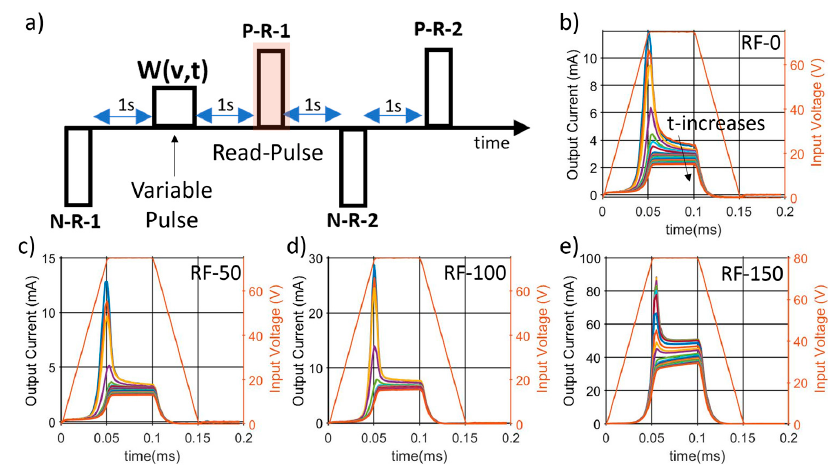
Figure 7. ( a ) Modified PUND method to analyze the polarization dynamic of the films. ( b – e ) Corre- sponding output read currents for different time-widths of the write pulse, from 50 μ s to 1 s, for all the switchable samples: ( b ) RF-0, ( c ) RF-50, ( d ) RF-100, and ( e ) RF-150.